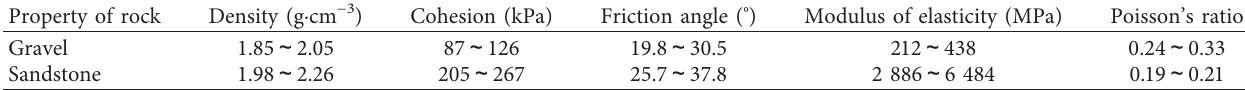
Table 1: Mechanical parameters of stratum.